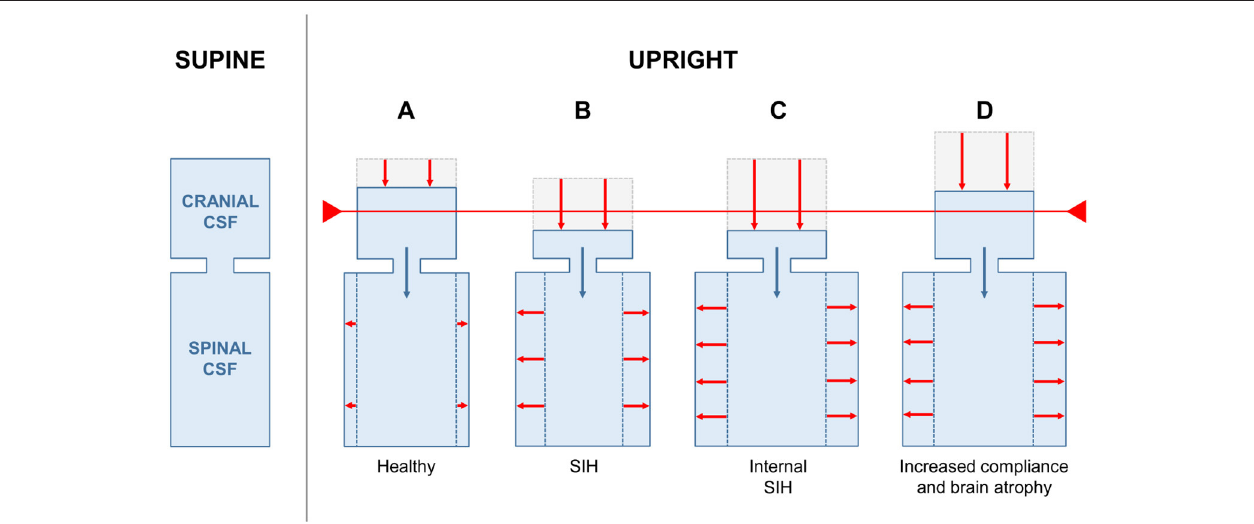
FIGURE 3 | Hypothetical CSF volume shifts in different constellations of SIH and healthy individuals. Schematic illustration of craniospinal CSF distribution in the supine (left) and upright position (right; A–D ). The red line indicates the threshold for development of orthostatic symptoms. In a healthy individual only a small proportion of the cranial CSF volume is shifted to the spinal compartment after a positional change (A) . CSF leakage in patients with classical SIH leads to CSF hypovolemia and a shift to the left on the pressure–volume curve with increased compliance. Thus, a larger volume (absolute and proportional) is shifted to the spinal compartment (B) . In a state of increased spinal compliance, a larger absolute volume is shifted to the spinal compartment (C,D) . In patients with normal or low intracranial CSF volume, the proportion of CSF shifted is large and causes internal SIH (C) . In patients with high intracranial CSF volume (e.g., because of brain atrophy) the proportionally smaller CSF shift is compensated and no symptoms occur (D)